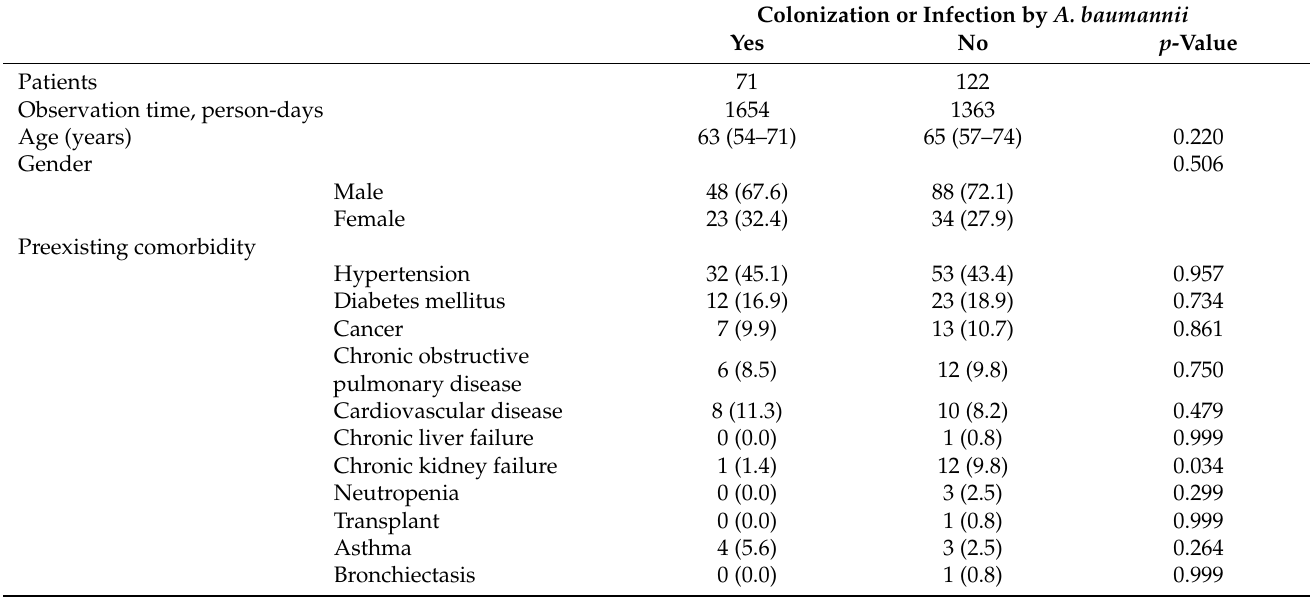
Table 2. Characteristics of the SARS-CoV-2 patients admitted to the intensive care unit of the